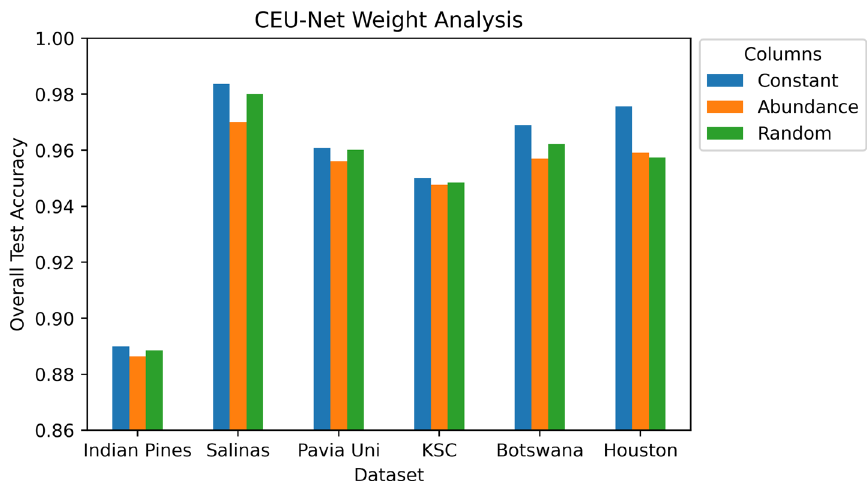
Fig. 4 Results of the loss weight ω = [ ω 1 , ... , ω k ] T tuning for our ensemble CEU-Net method. Three different weight types are explored: 1) Constant weights in each sub-model, 2) Weights equaling the abundance of data given to each sub-model, and 3) Random weights assigned. All weights have to sum to equal 1 as explained in Eq. 2. All tests were run with 5-fold cross-validation. We observed that the constant weights outperform other methods, therefore, we use constant weights in all of our CEU-Net experiments